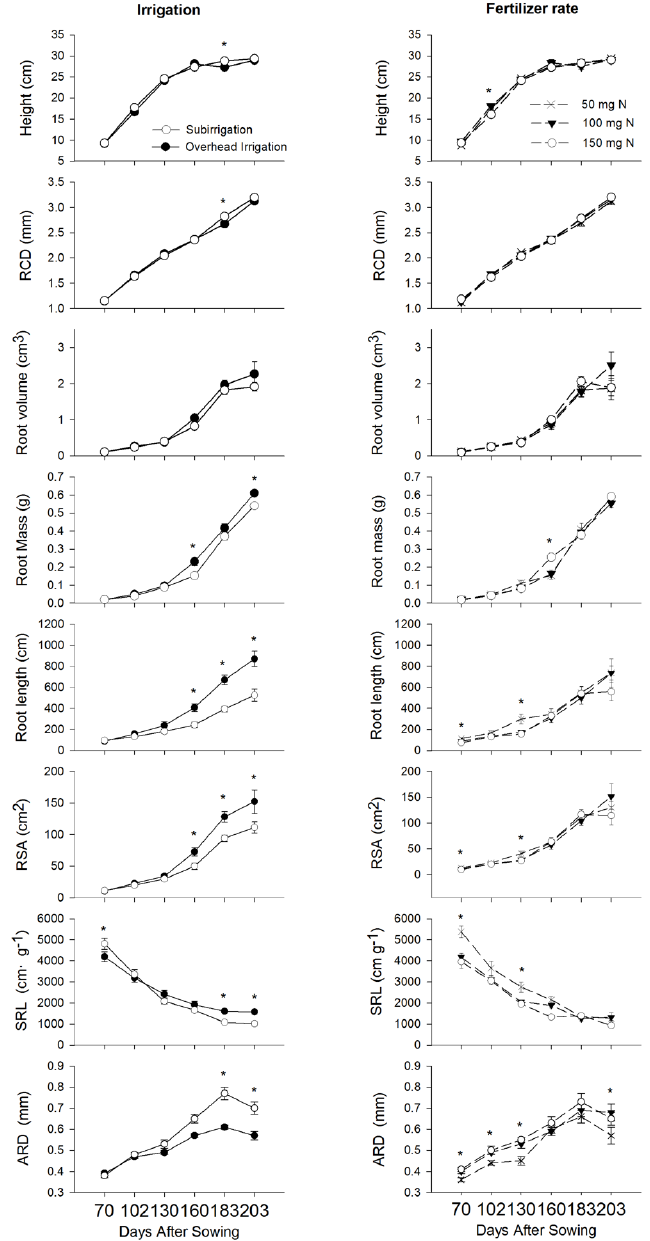
Figure 1. Height, RCD (root collar diameter), root volume, root mass, root length, RSA (root surface area), SRL (specific root length) and ARD (average root diameter) for 70 to 203 days-old larch seedlings watered either from overhead irrigation or subirrigation (left panel) or grown with three fertilizer rates (right panel). An asterisk indicates a significant difference with a given irrigation treatment according to Tukey’s honestly significant difference test at α = 0.05.